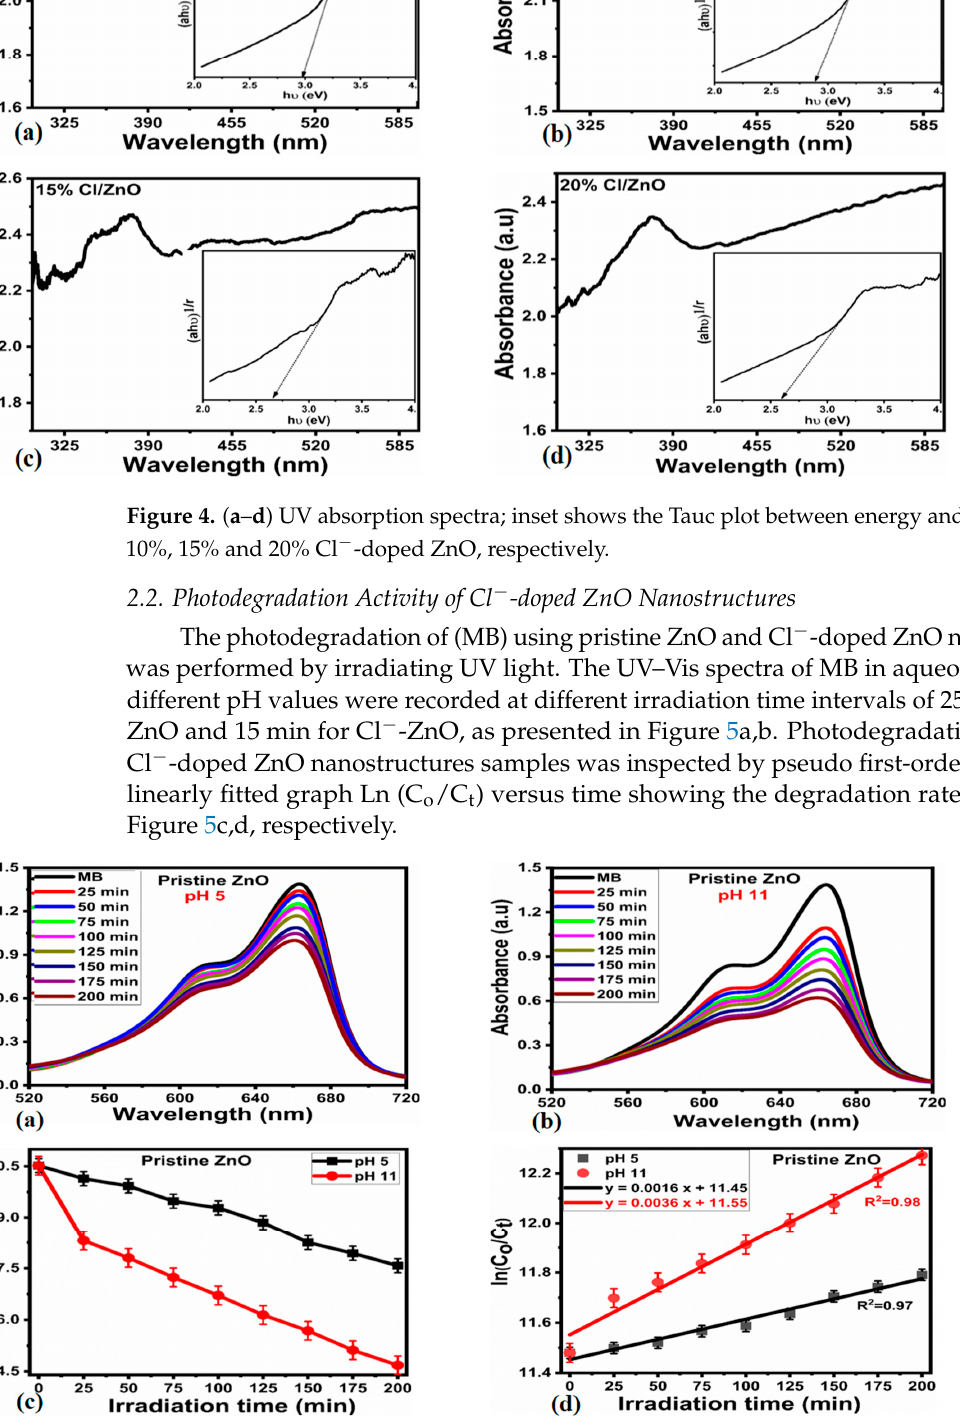
Figure 5. ( a , b ) UV–Vis absorbance spectrum of MB at certain intervals for pristine ZnO at pH 5 and pH 11. ( c ) C t /C o versus time. ( d ) Linearly fitted graph Ln (C o /C t ) versus time showing degradation rate.